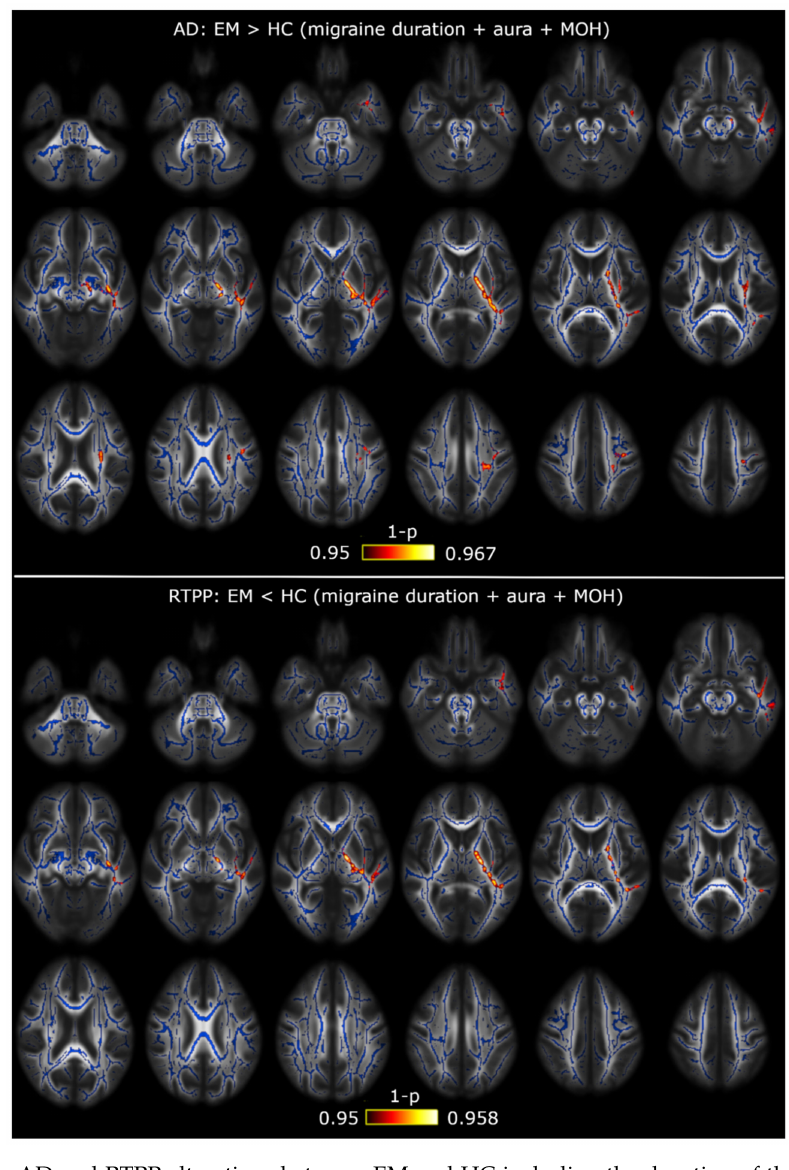
Figure A6. AD and RTPP alterations between EM and HC including the duration of the migraine, presence of aura and medication overuse headache as covariates. TBSS showed increased AD and decreased RTPP values in EM with respect to HC. The white matter skeleton is shown in blue, and voxels with the lowest p -values in red-yellow. The color bar shows the 1- p -values (FWE-corrected). MOH = medication overuse